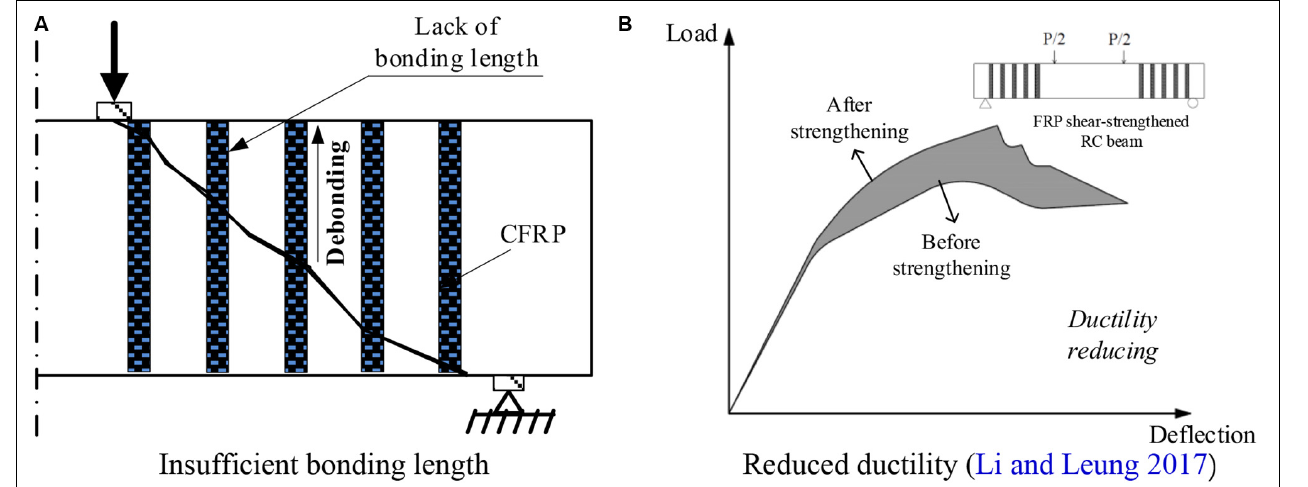
FIGURE 1 | Problems of EB-FRP technology. (A) Insufficient bonding length. (B) Reduced ductility (Li and Leung,